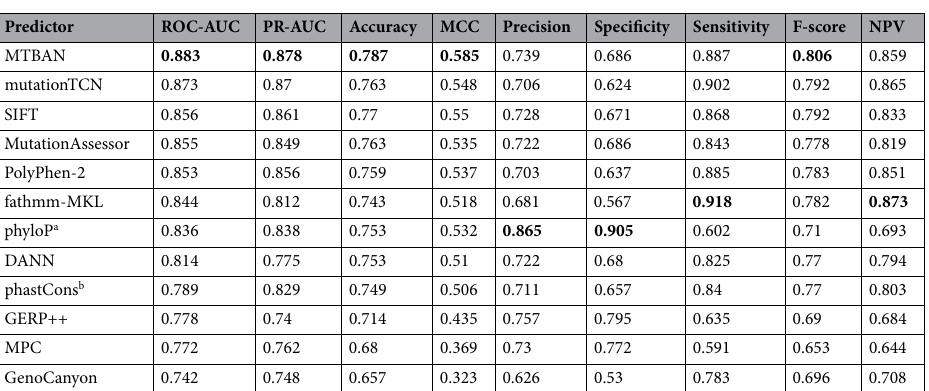
Table 2. Performances of MTBAN and other predictors on the test dataset consisting of 1709 deleterious and 1709 benign variants. Since the score cutoffs for phyloP, DANN, phastCons, GERP++, MPC, and GenoCanyon were not provided by dbNSFP, we computed the cutoffs for each predictor using the Humsavar database (release 03/2021) as described in “Methods” section. The highest values for each evaluation metric are indicated in bold. ROC-AUC, Receiver Operating Characteristic Area Under Curve; PR-AUC, Precision-Recall Area Under Curve; MCC, Matthews Correlation Coefficient; NPV, Negative Predictive Value. a